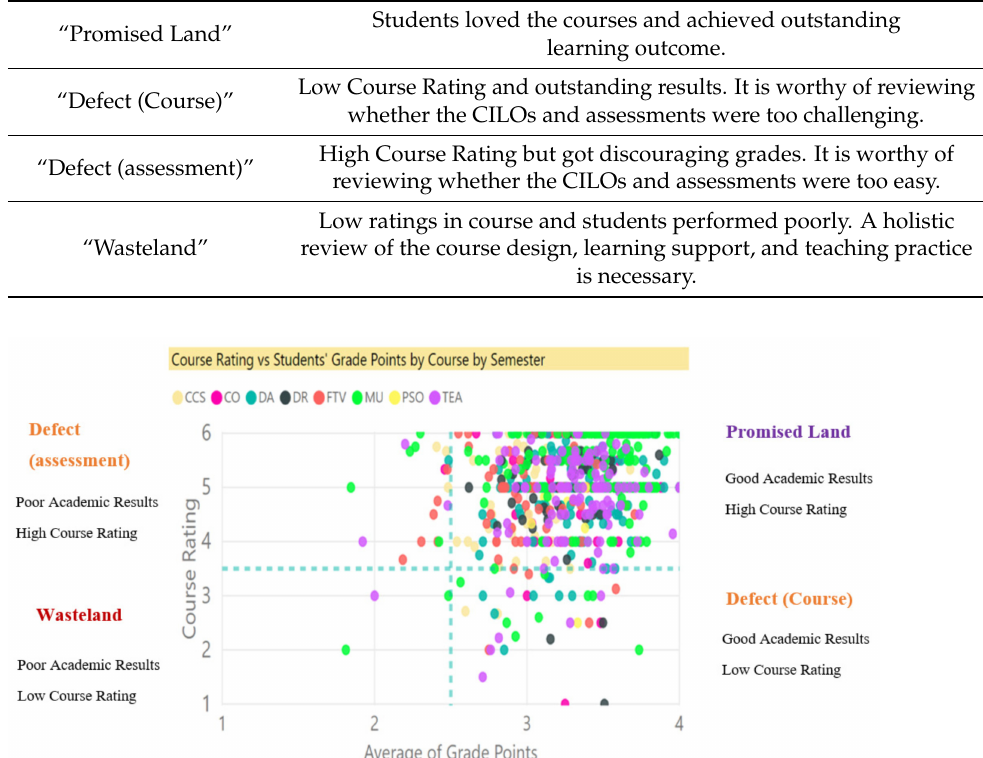
Figure 17. Grade Points–Course Rating Matrix. Note: (1) In the visual, each data point represents the average course rating given by students, and students’ grade for a particular